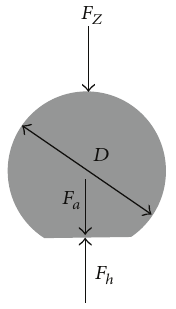
Figure 2: Applied forces on the